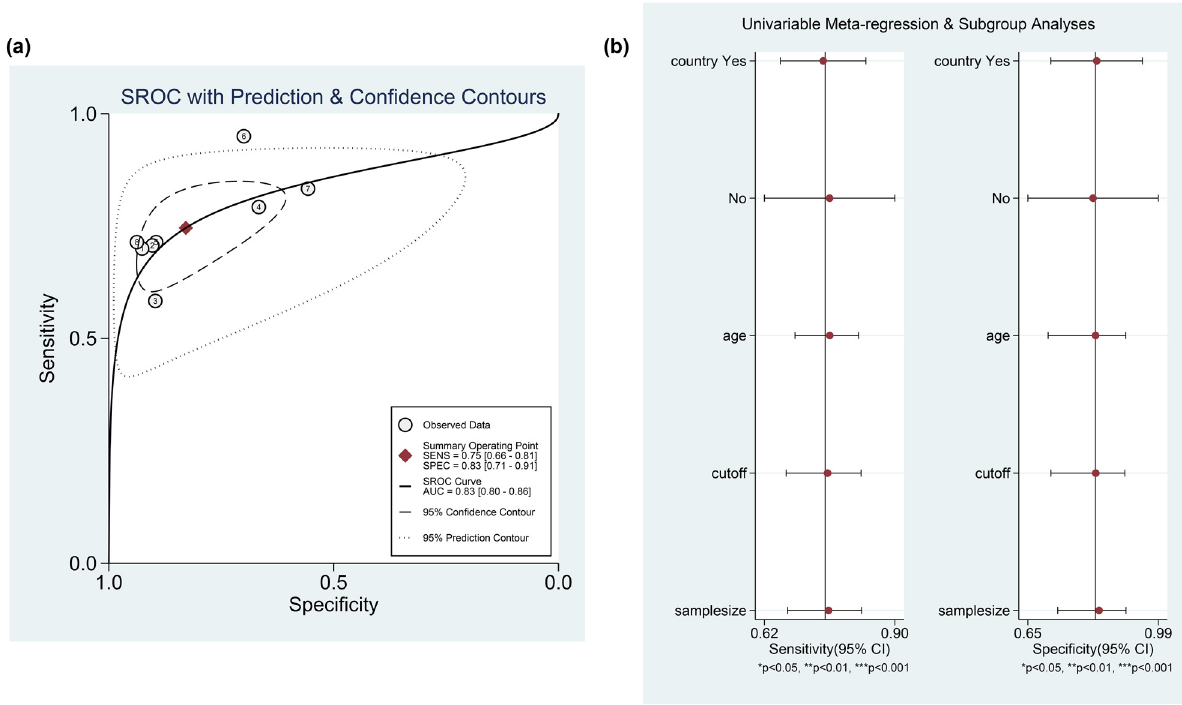
Figure 5: Serum I - FABP for the diagnosis of strangulated intestinal obstruction. A. ROC curve. B. Meta -